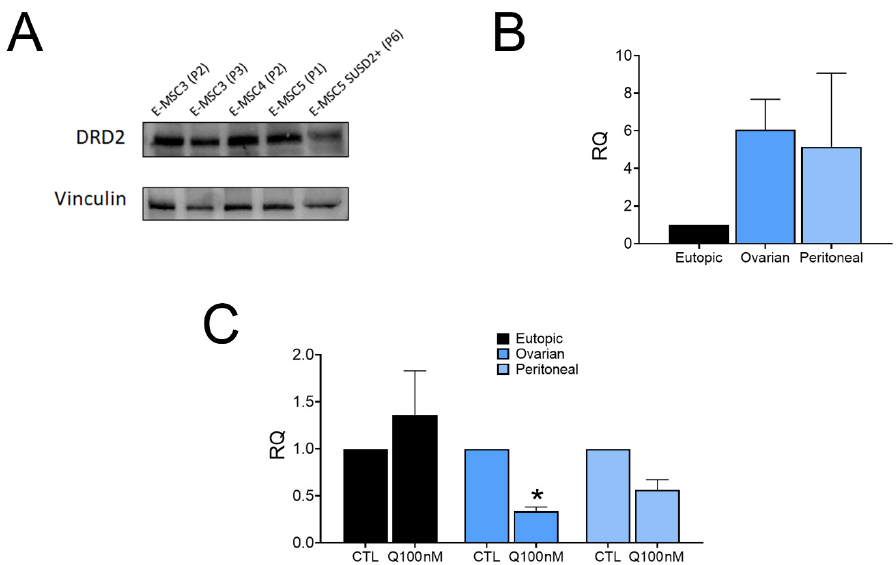
Figure 2. Effect of quinagolide on DRD2 expression in eutopic and ectopic E-MSCs. ( A ) Western blot analysis showing the presence of DRD2 in E-MSC lines, at different passages, and in sorted SUSD2+ E-MSCs. ( B ) Real-Time PCR analysis showing the relative quantification (RQ) of DRD2 mRNA expression by eutopic and ectopic E-MSCs. Data are represented as mean ± SD of three different eutopic or ectopic (ovarian and peritoneal) lines, and normalized to GAPDH and to eutopic E-MSCs. ( C ) Real-Time PCR analysis showing DRD2 mRNA expression after 48 h of 100 nM quinagolide treatment (Q100 nM) by eutopic and ectopic E-MSCs. Data are represented as mean ± SD of three different eutopic or ectopic (ovarian and peritoneal) lines, and normalized to GAPDH and to untreated E-MSCs (CTL). ANOVA was performed: * = p < 0.05 vs. CTL.